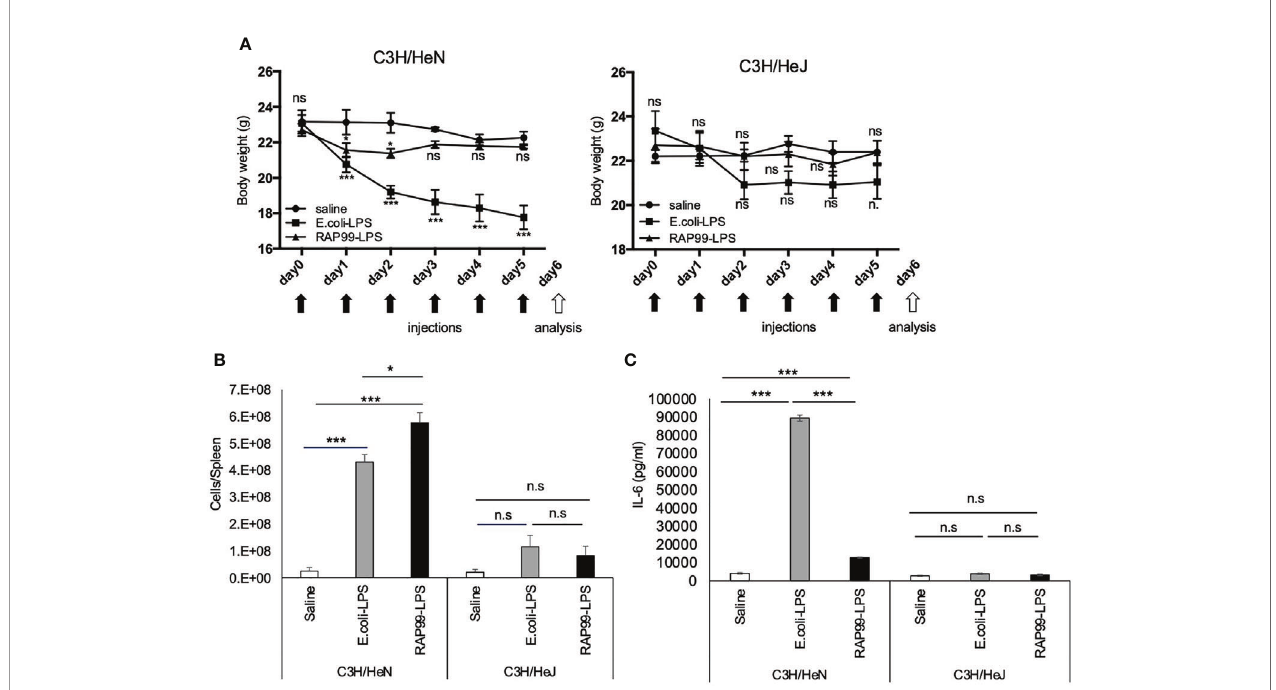
FIGURE 5 | TLR4 is involved in RAP99-LPS-mediated immune activation in vivo . E . coli -LPS (50 m g/day), RAP99-LPS (50 m g/day), or saline was intraperitoneally injected into C3HHe/N mice and C3HHe/J mice for 9 days to investigate (A) body weight, (B) the number of splenocytes, and (C) IL-6 serum level. Mice injected with E. coli -LPS and RAP99-LPS were compared with mice injected with saline (A) . Mean scores ± SD are shown. Saline (n = 4), E. coli -LPS (n = 5), RAP-LPS (n = 5). Black arrows: injections. White arrow: analysis. (Representative data are shown.) *p < 0.05, ***p < 0.005; n.s., not signi fi cant.